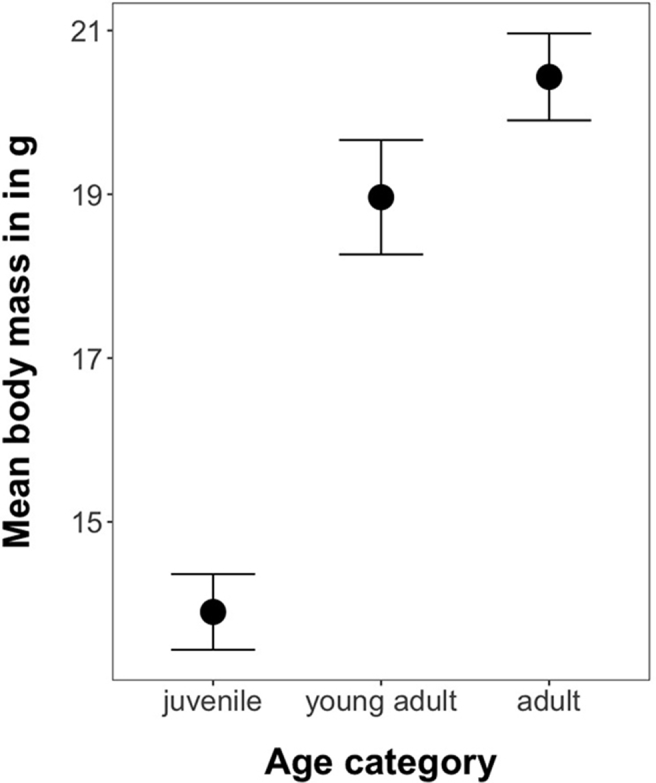
Mean (+/− Standard error) differences in body mass between age categories.